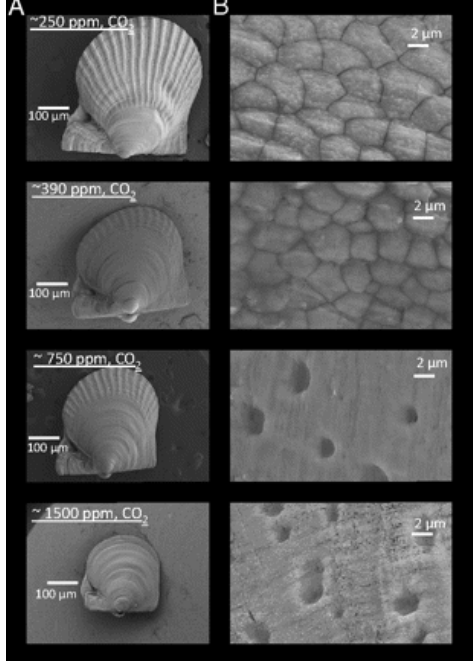
Figure 1. Impacts of increasing ocean CO 2 levels on clams. Figure reprinted from [37] with permission from the Proceedings of the National Academy of Sciences of the United States of America. ( A ) Image of full individual larvae under specified CO 2 level. ( B ) A magnification of the outermost shell of individuals under specified CO 2 level.